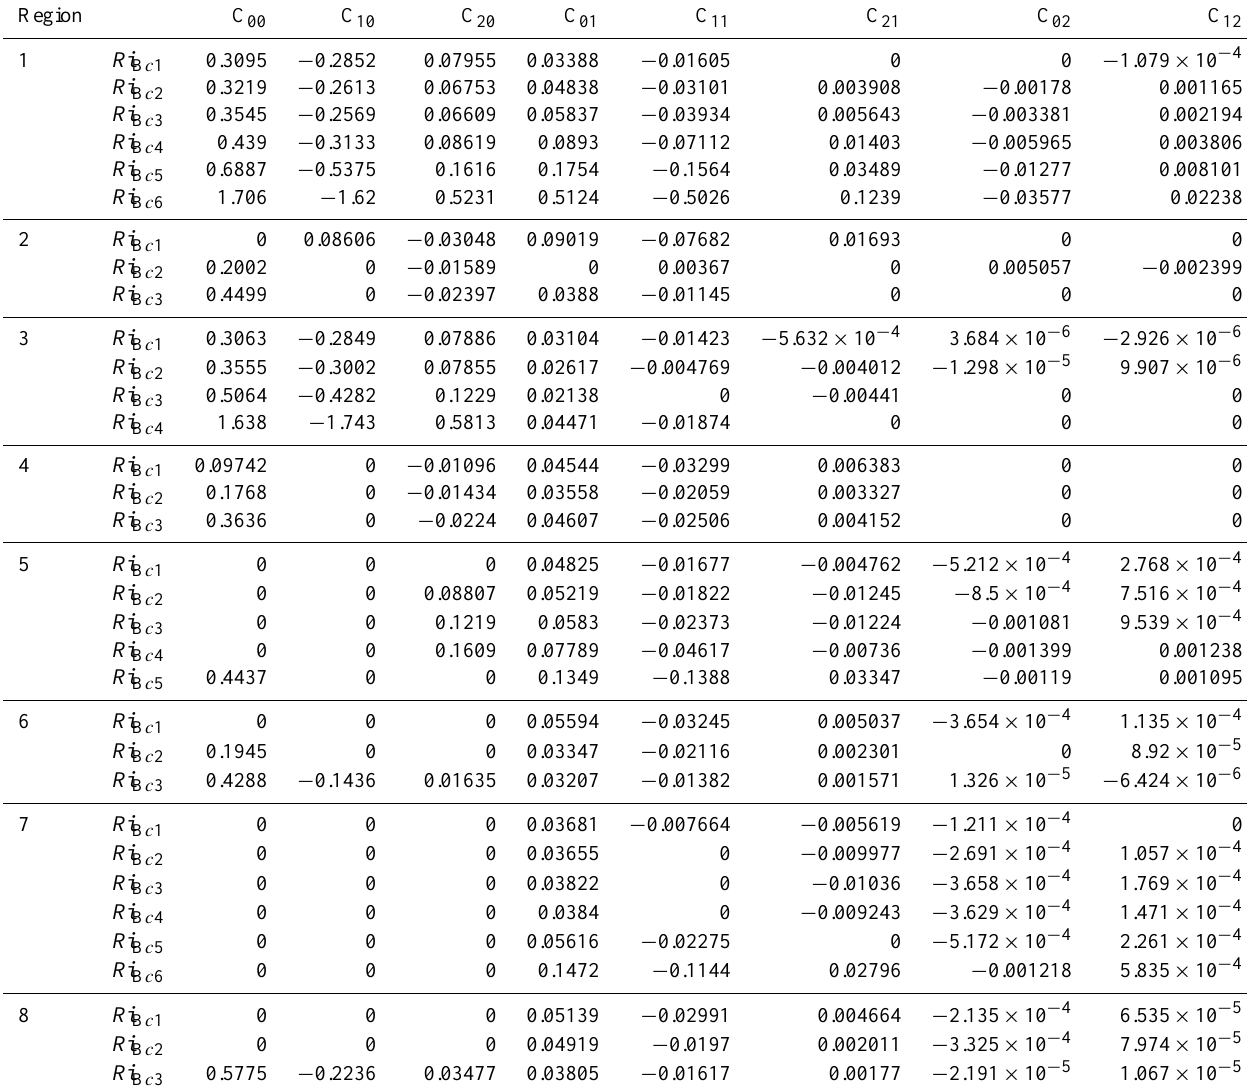
Table 2. The coefficients of Eq.